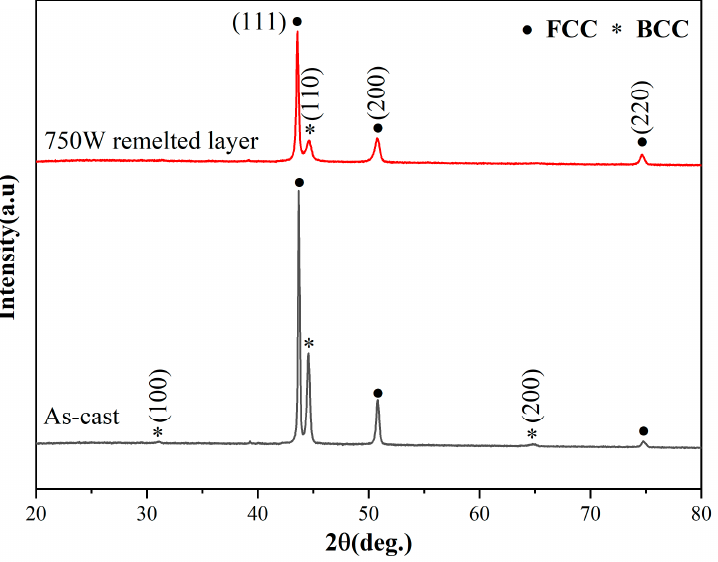
Figure 1. XRD analysis of the cast AlCoCrFeNi 2.1 HEA and 750 W remelted